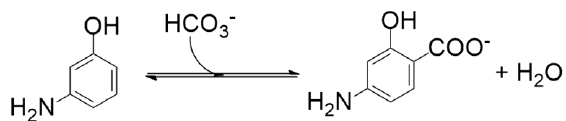
Figure 8. Reversible carboxylation reactions catalyzed by salicylic acid decarboxylase enzyme from Trichosporon moniliiforme WU-0401 yeast.